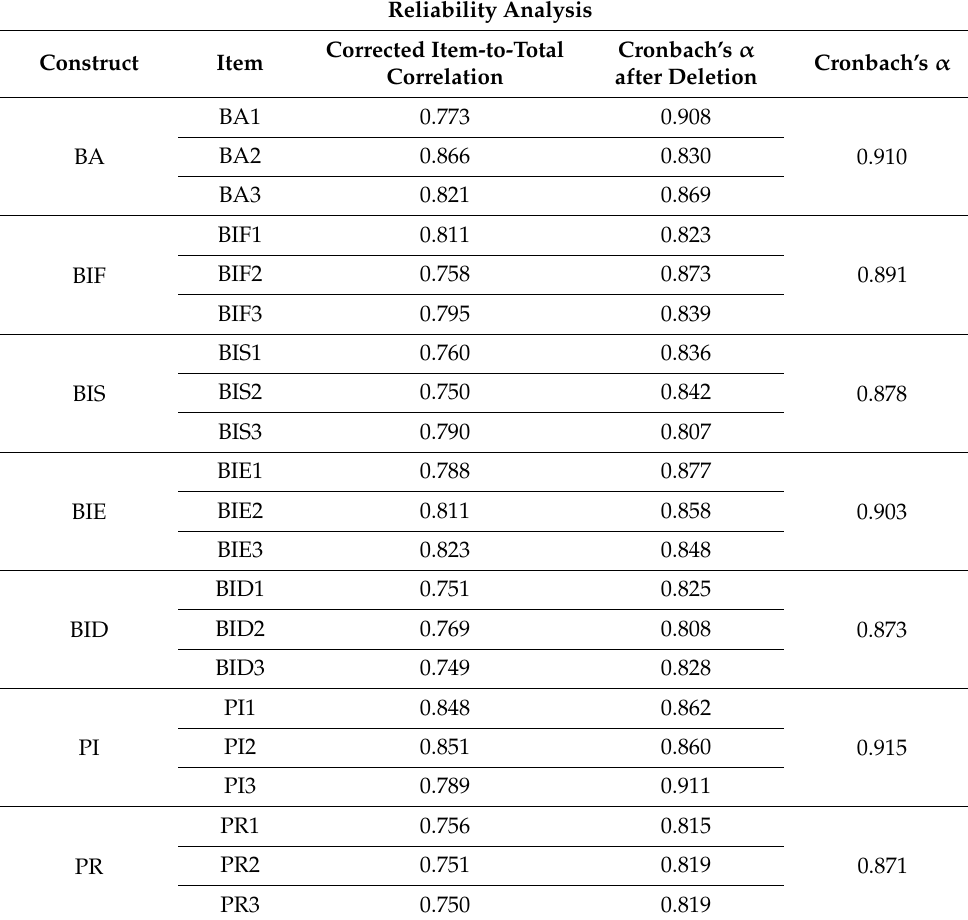
Table 3. Reliability analysis.